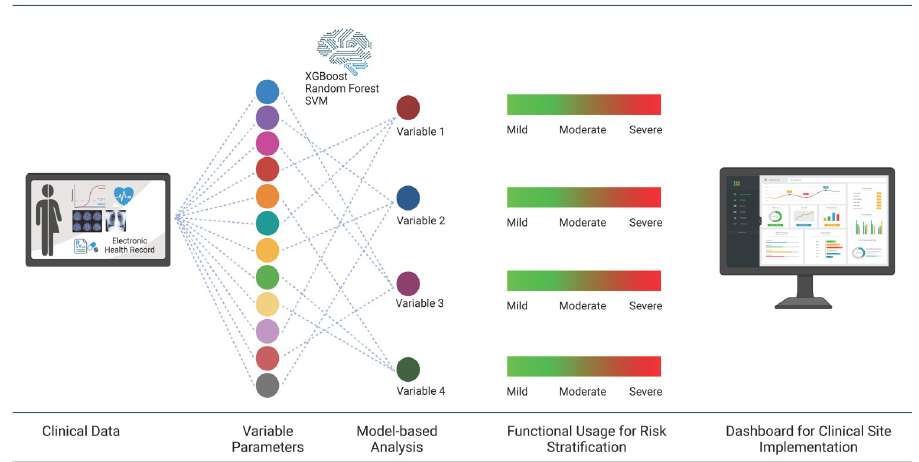
Fig 8. Model-based analysis of clinical data for risk stratification with potential clinical implementation. Machine learning model-based analysis of clinical data variables to identify parameters for risk stratification, and development of dashboard for implementation of the model at the clinical